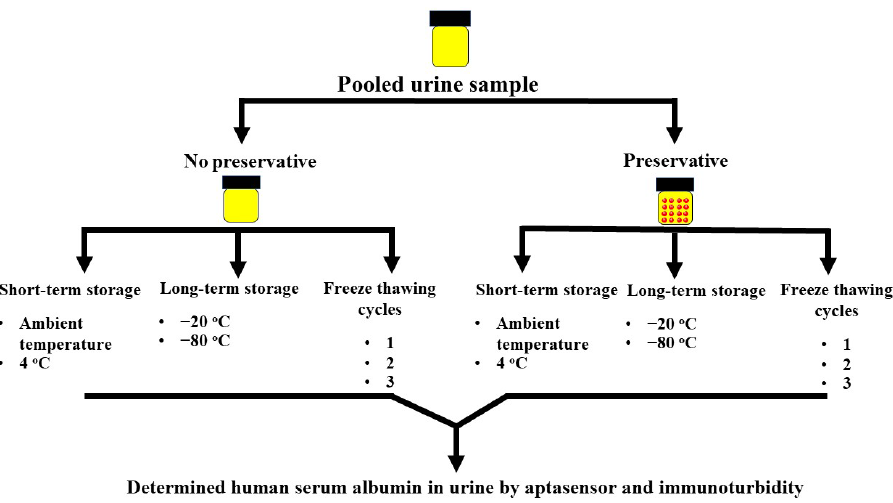
Figure 2. Schematic diagram showing the study design.